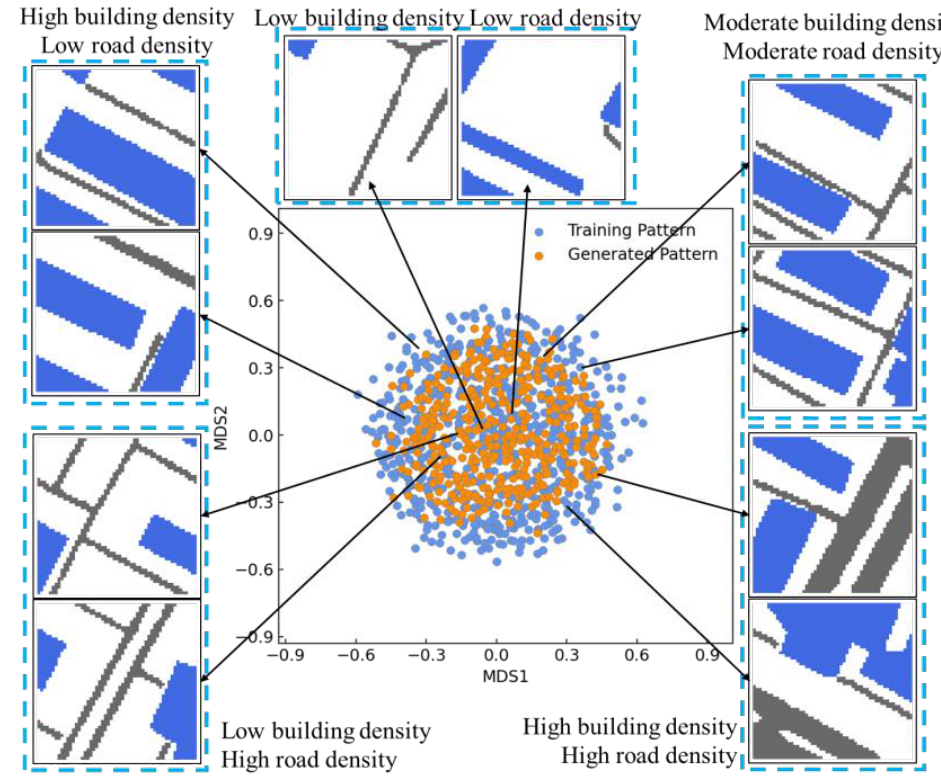
Figure 7. Multidimensional scaling result on the urban fabric images.